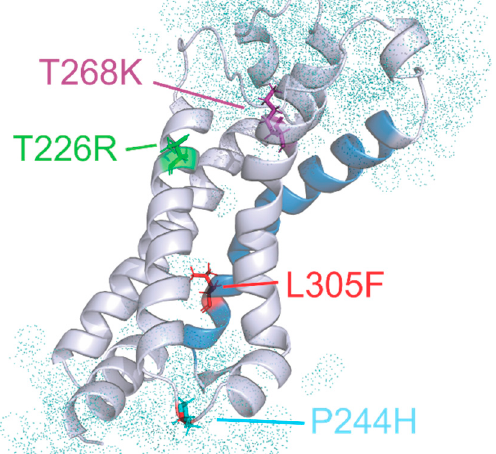
Figure 6. Side view of the voltage sensor domain from the homology model of Kv1.1. The pore domain, membrane, and the other three voltage sensors are removed for clarity. The S4 is shown in blue. The mutations related to neuromyotonia without significant ataxia are highlighted as stick models. Water molecules are shown as dot spheres.